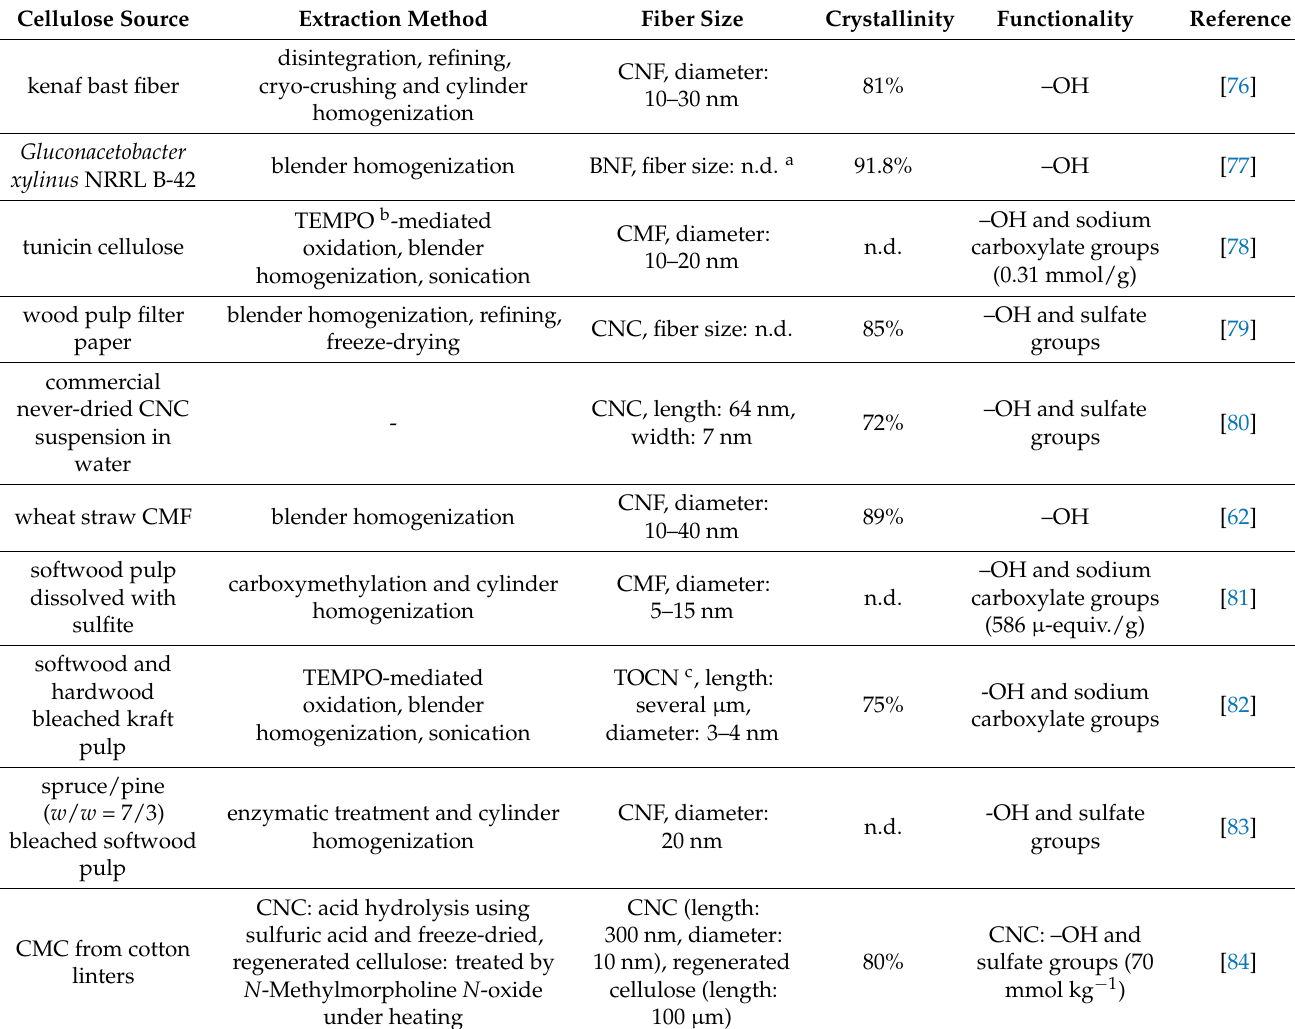
Table 1. Extraction methods and properties of cellulose from diverse natural